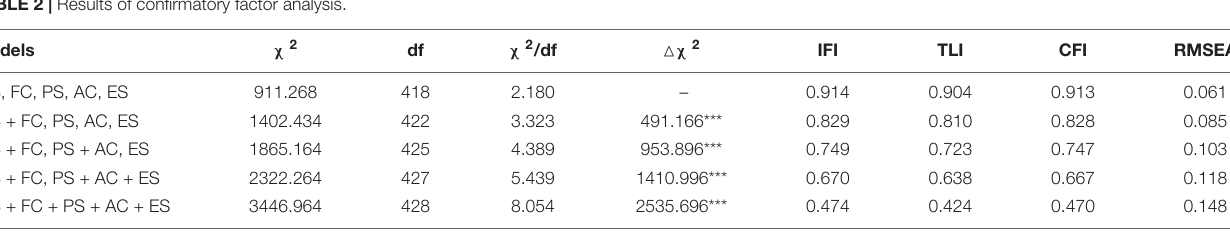
TABLE 2 | Results of confirmatory factor analysis.